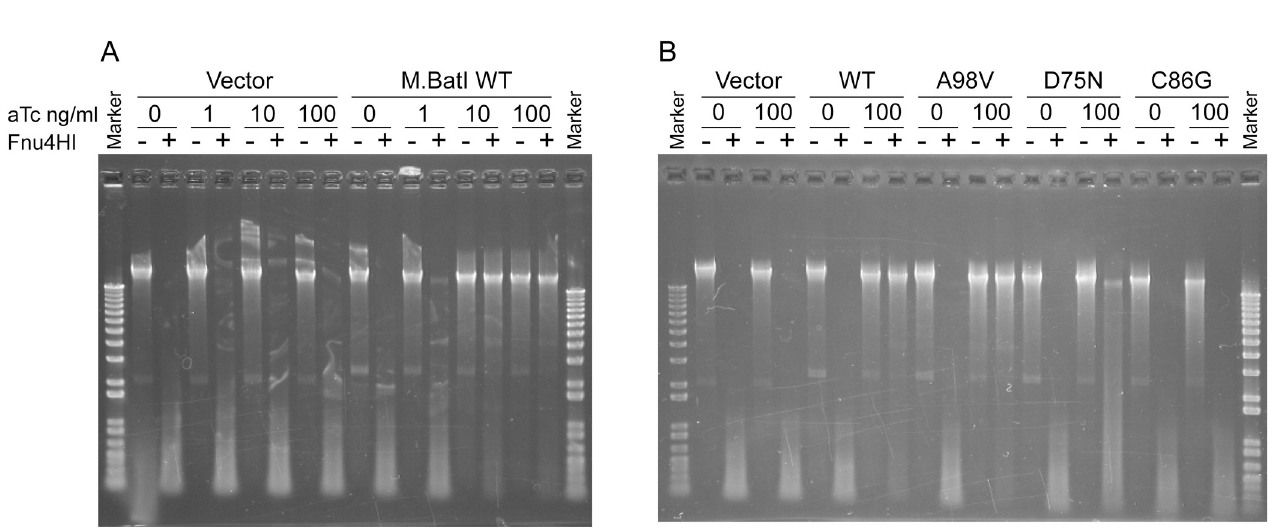
Fig 5. Genomic DNA modification by M.BatI with different levels of induction and mutations. (A) Digestion of genomic DNA induced with different concentrations of aTc. (B) Digestion of genomic DNA modified by M.BatI variants.